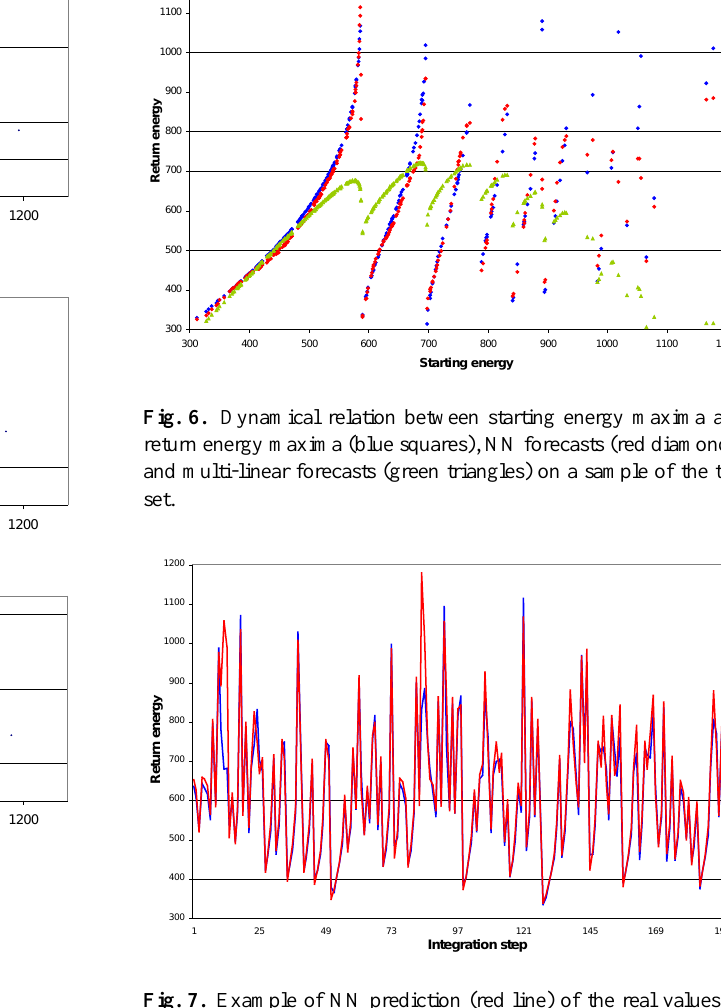
Fig. 7. Example of NN prediction (red line) of the real values of maximum return energy (blue line) on a subset of the test